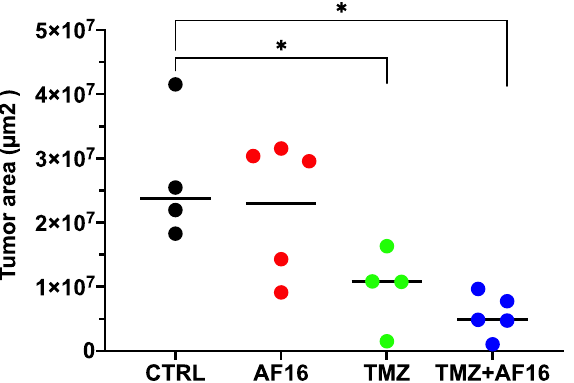
Figure 2. AF16 + TMZ combination and TMZ alone decrease tumor area in GL261-bearing C57BL/6 mice. When the first animal showed tumor symptoms, the whole cohort was sacrificed and tumor area was analyzed in brain sections. TMZ + AF16 compared to controls p = 0.016 *, TMZ alone compared to controls p = 0.029 *; both nonparametric Mann–Whitney U tests. Values are shown in µm 2